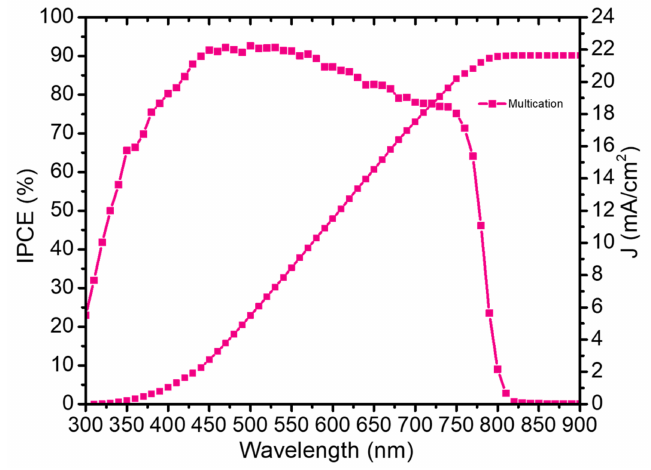
Figure 7. EQE measurement of the best multication solar cells fabricated by two-step deposition.